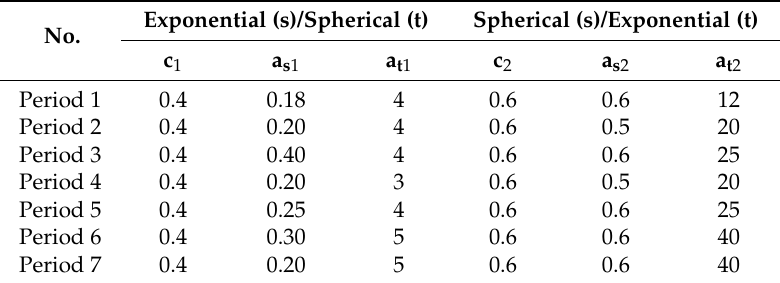
Table 3. Parameters of the covariance models.